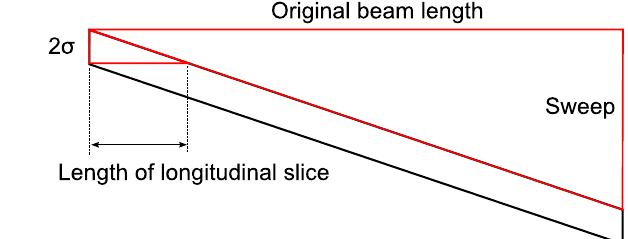
FIG. 7. The boundary of the beam with finite spot size and related